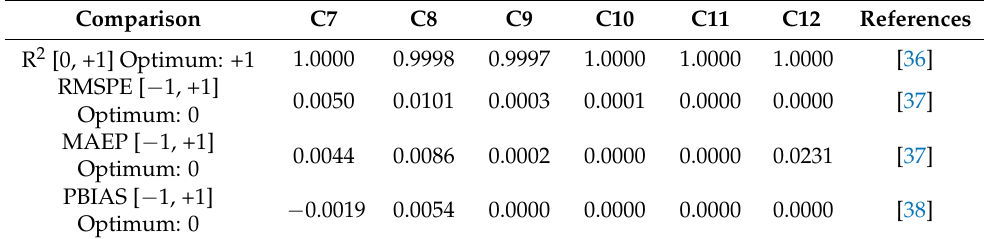
Table 4. Metrics of the proposed